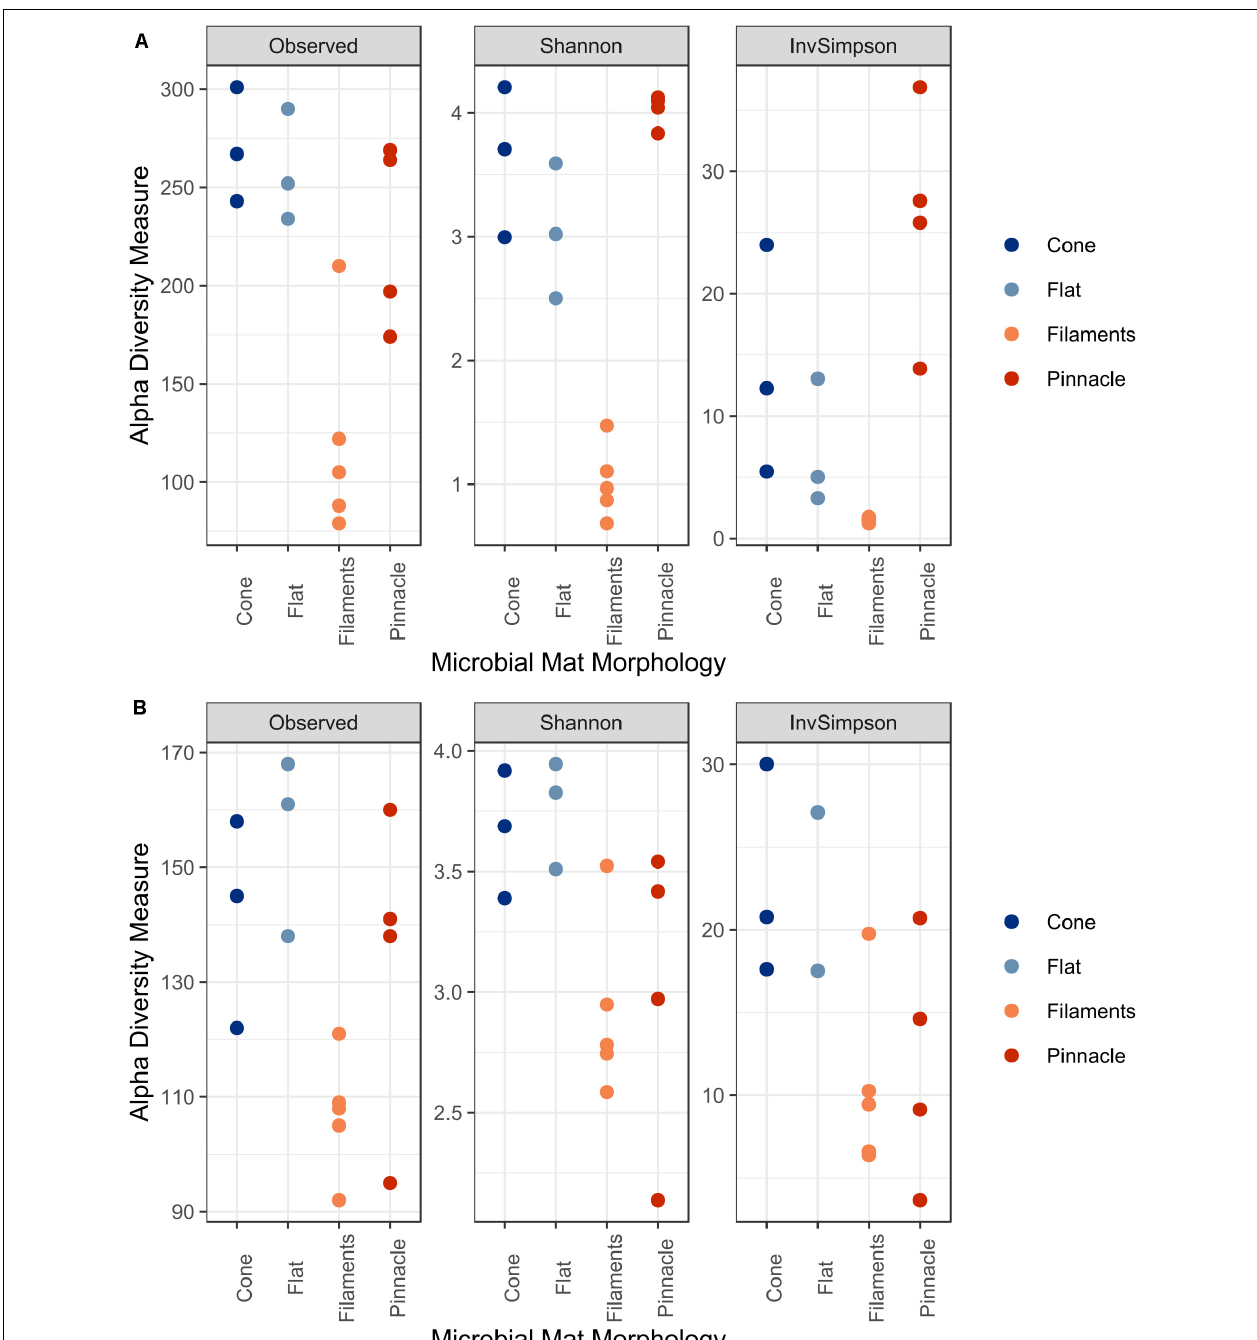
FIGURE 7 | The alpha diversity indices Observed, Shannon and InvSimpson for (A) 16S and (B) 18S rRNA datasets.